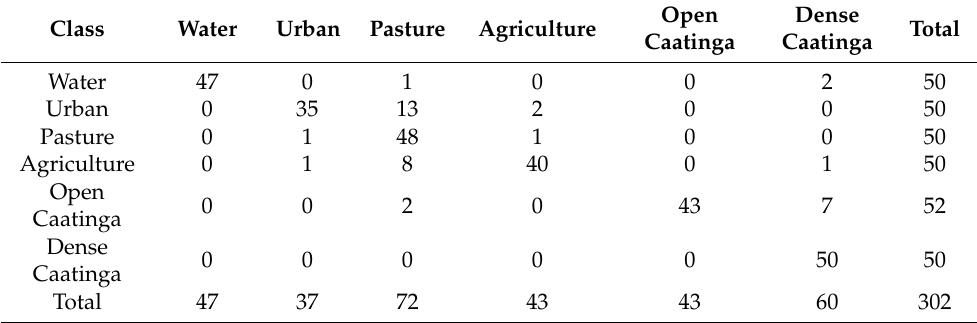
Table A1. Confusion matrix year